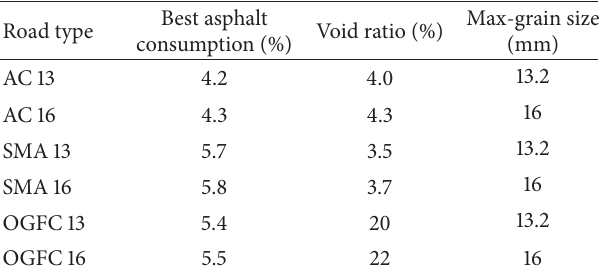
Table 1: The properties of asphalt road